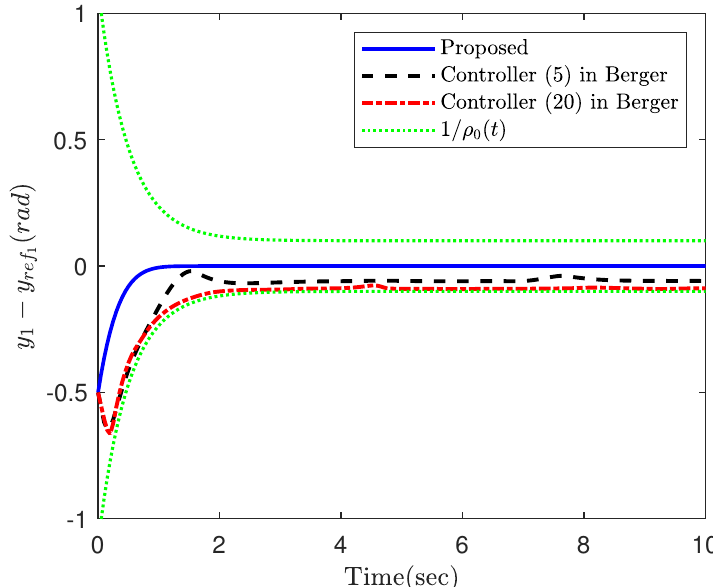
Figure 7. The tracking error of the first joint in Part 2.